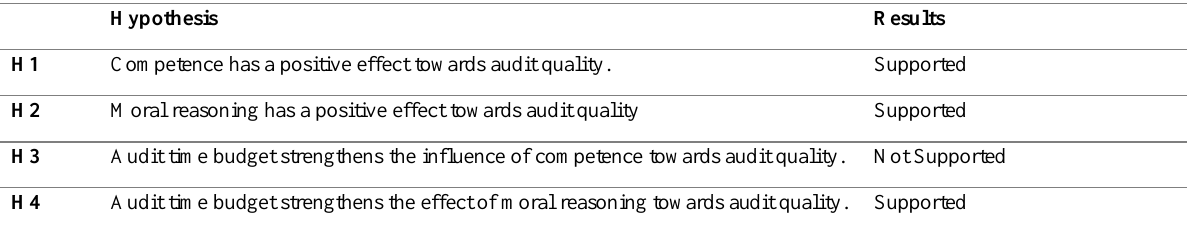
Table 7: Summary of Hypothesis Testing